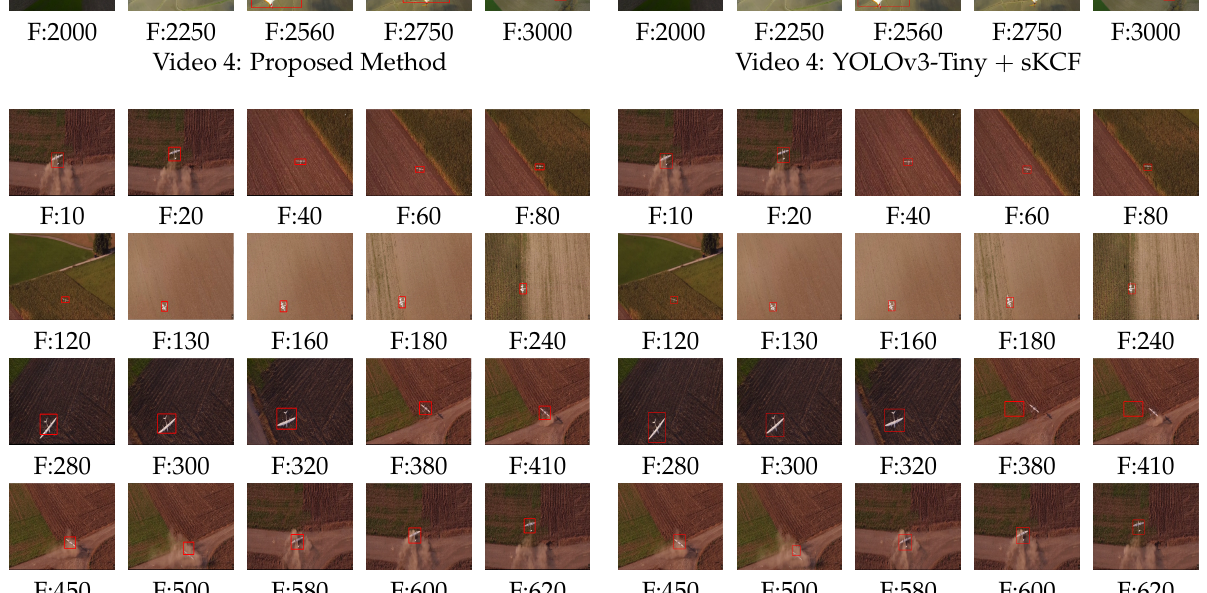
Figure 6. Illustration of UAV tracking results in different video frames using proposed framework and YOLOv3-tiny with the sKCF